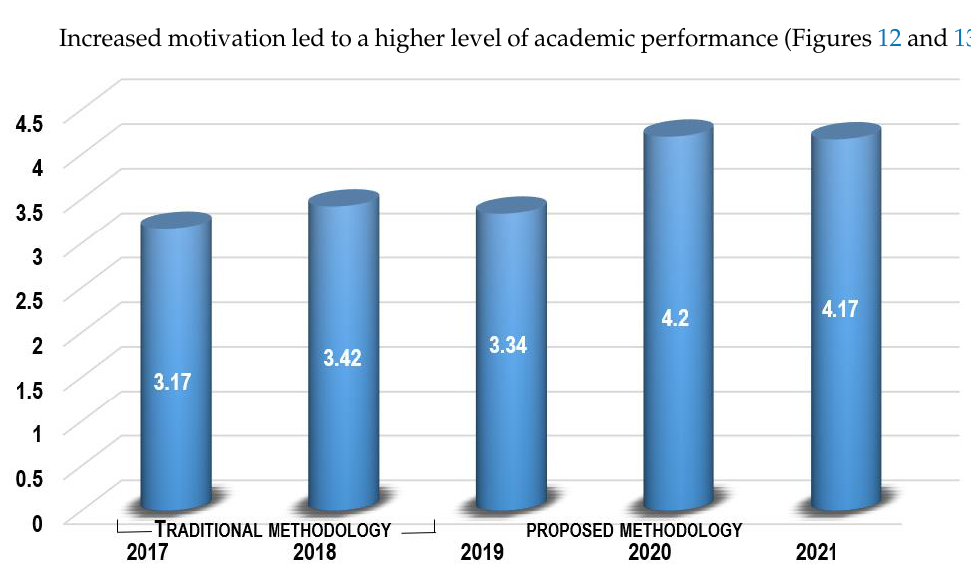
Figure 13. Distribution of exam results. The results of a teachers ’ survey allows us to say that the environment and the scene in the virtual laboratory are similar to the real physical environment at vehicle service enterprises, and the scenario laid down in the virtual laboratory corresponds to the tech- nological process of balancing a vehicle wheel (Figure 14).